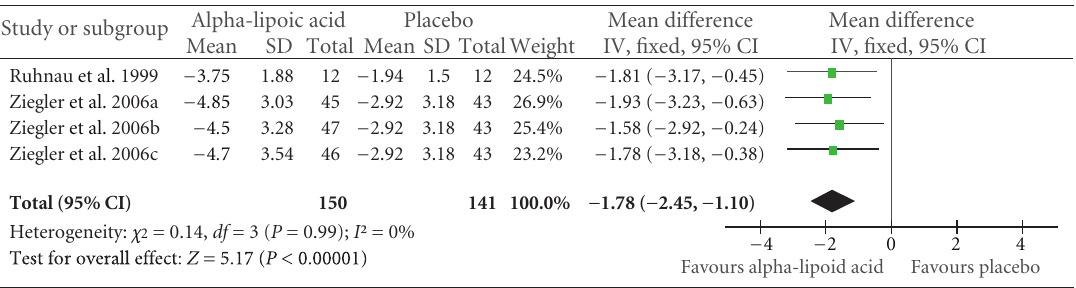
Table 6: Standardized mean di ff erences for the administration of orally administered alpha-lipoic acid versus placebo in the treatment of neuropathic pain. Diamond denotes pooled estimate of overall e ff ect. Weighing of individual studies is based on the inverse variance method. For subgroups, see Table